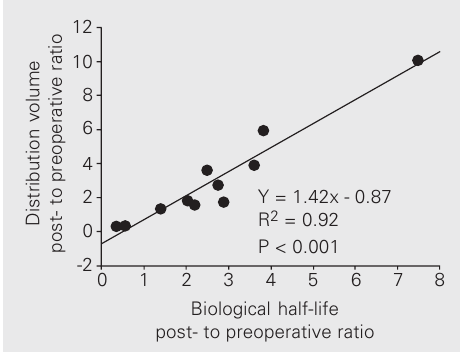
Figure 2. Correlation between the distribution volume post- operative:preoperative ratio and the postoperative:preoperative biological half-life ratio of pro-